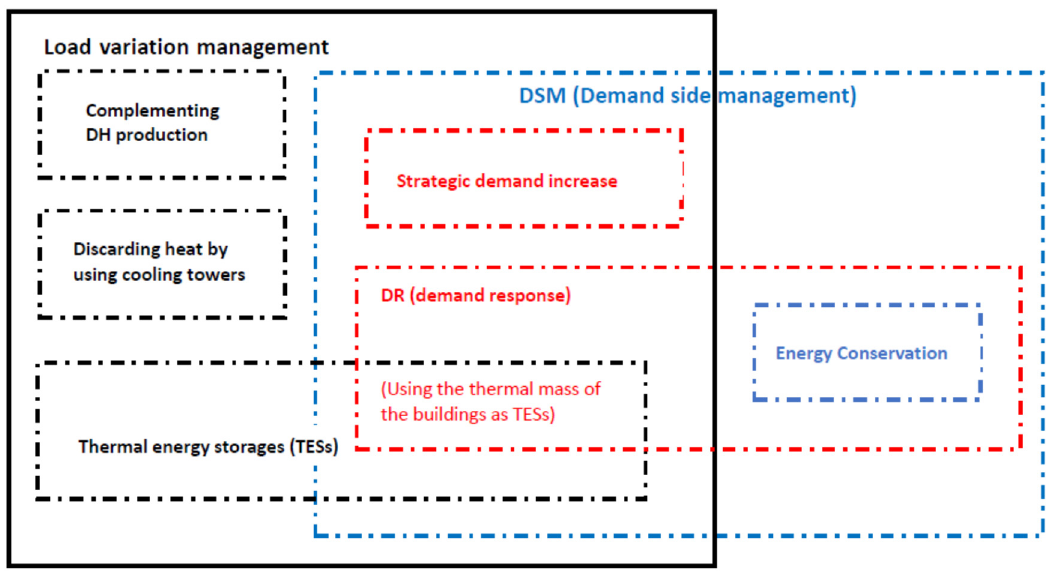
Figure 3. The proposed general categorization of the DH load management measures.